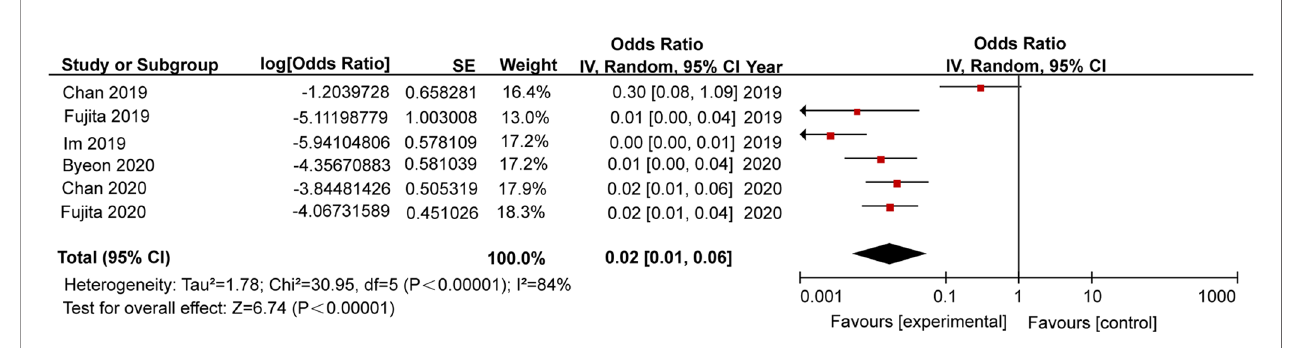
FIGURE 2 | Incidence of tuberculosis among patients treated with PD-1/PD-L1 blockade.